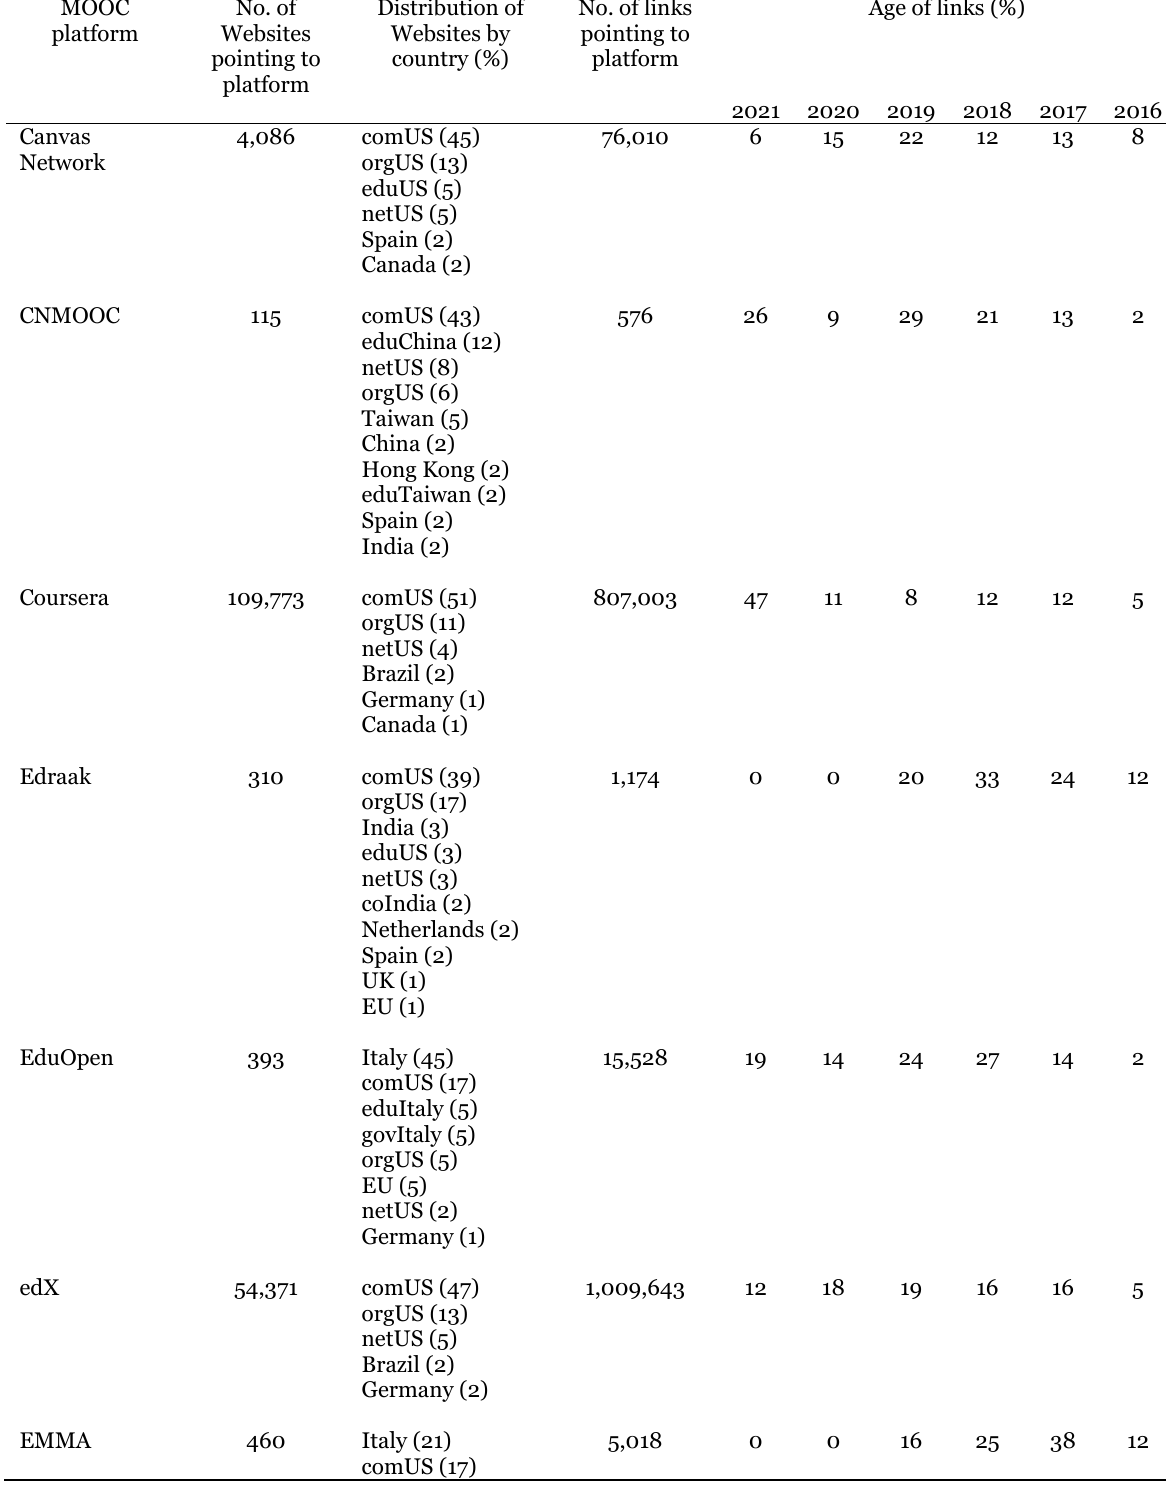
Table 5 MOOC Platforms ’ Popularity: Websites and Links MOOC platform